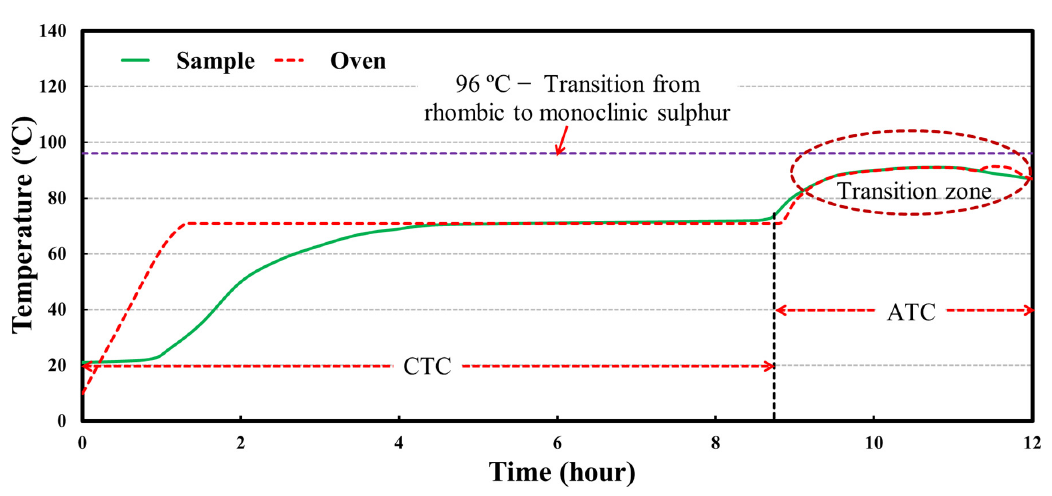
Figure 9. Thermograph of a test sample that did not pass the transition temperature.